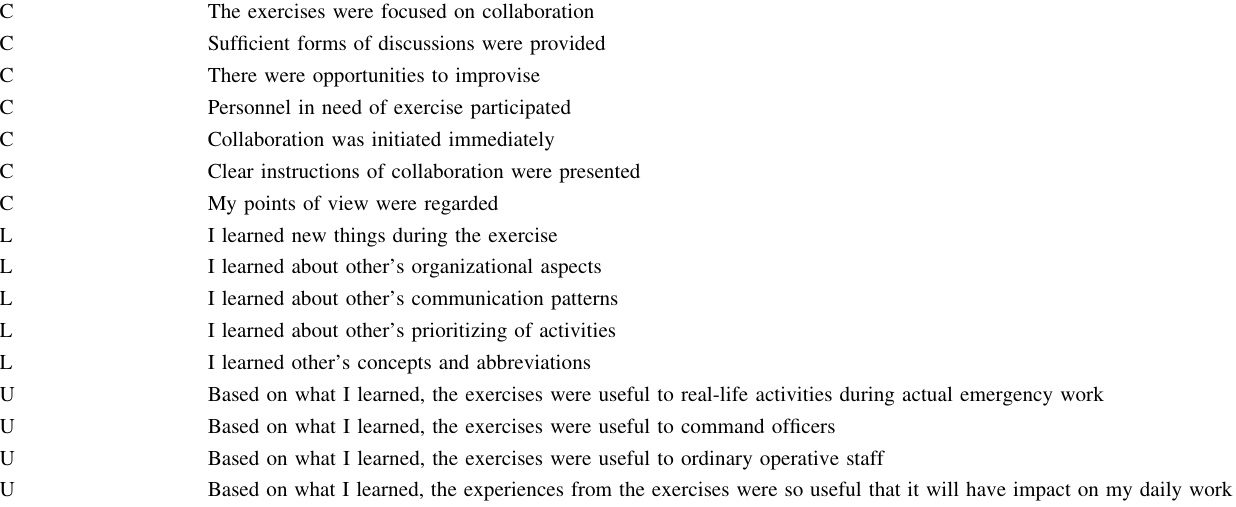
Table 1 Collaboration, Learning, and Utility scale